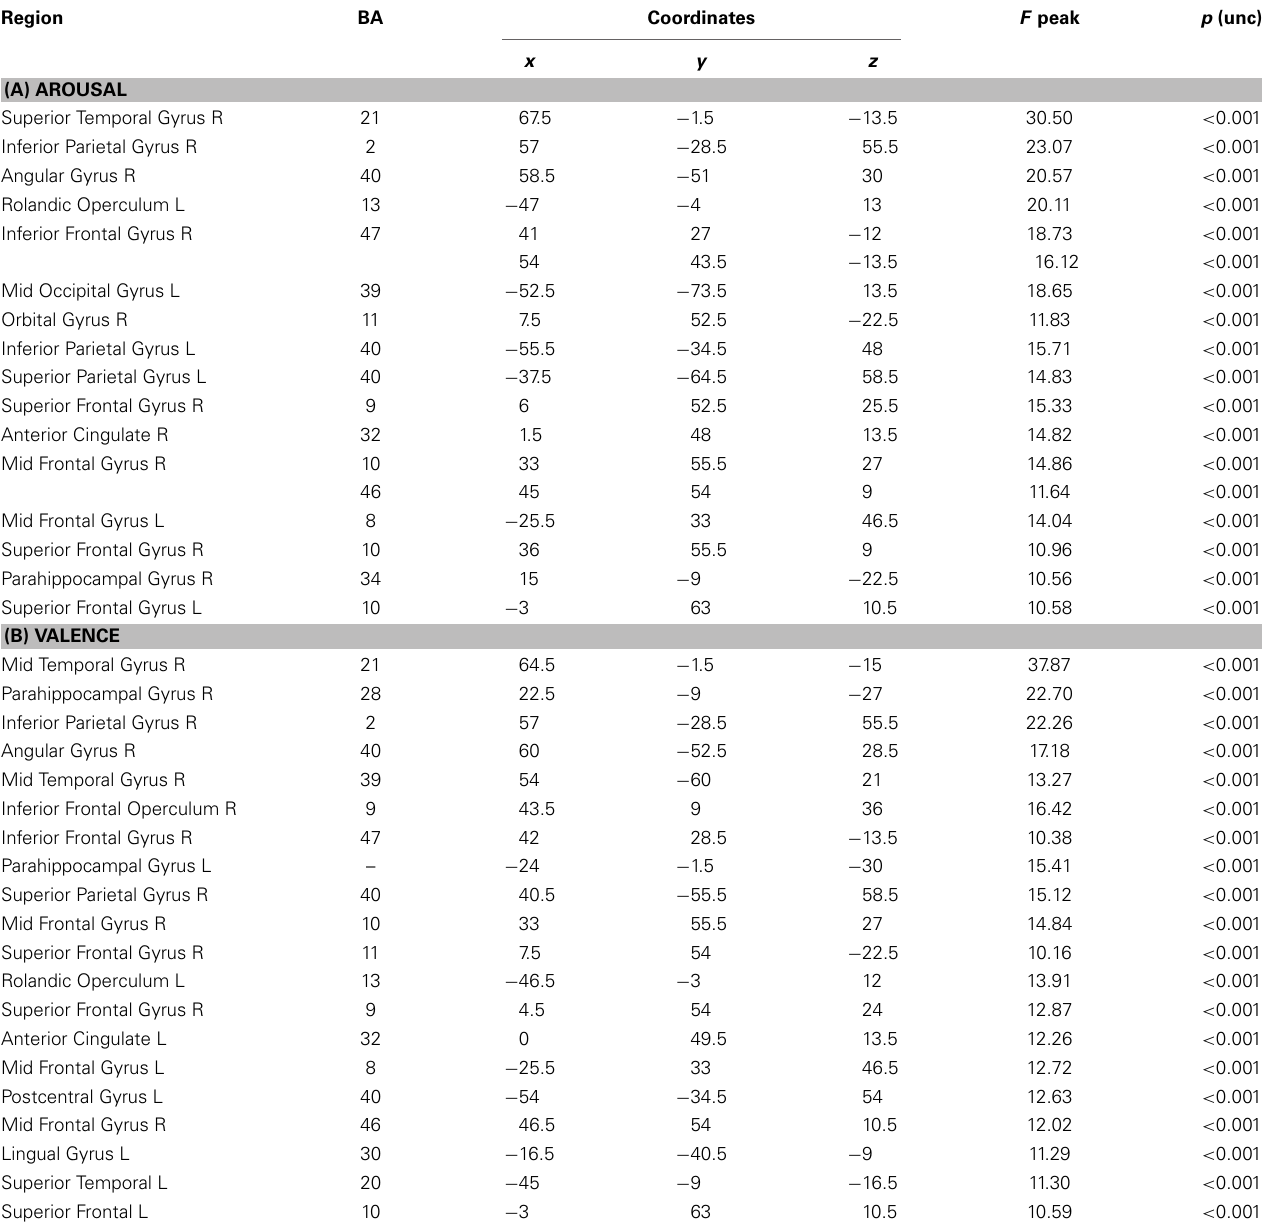
Table 5 | Whole brain Patterns of GM volume correlated with task performance in controls. Region BA Coordinates F peak p (unc)